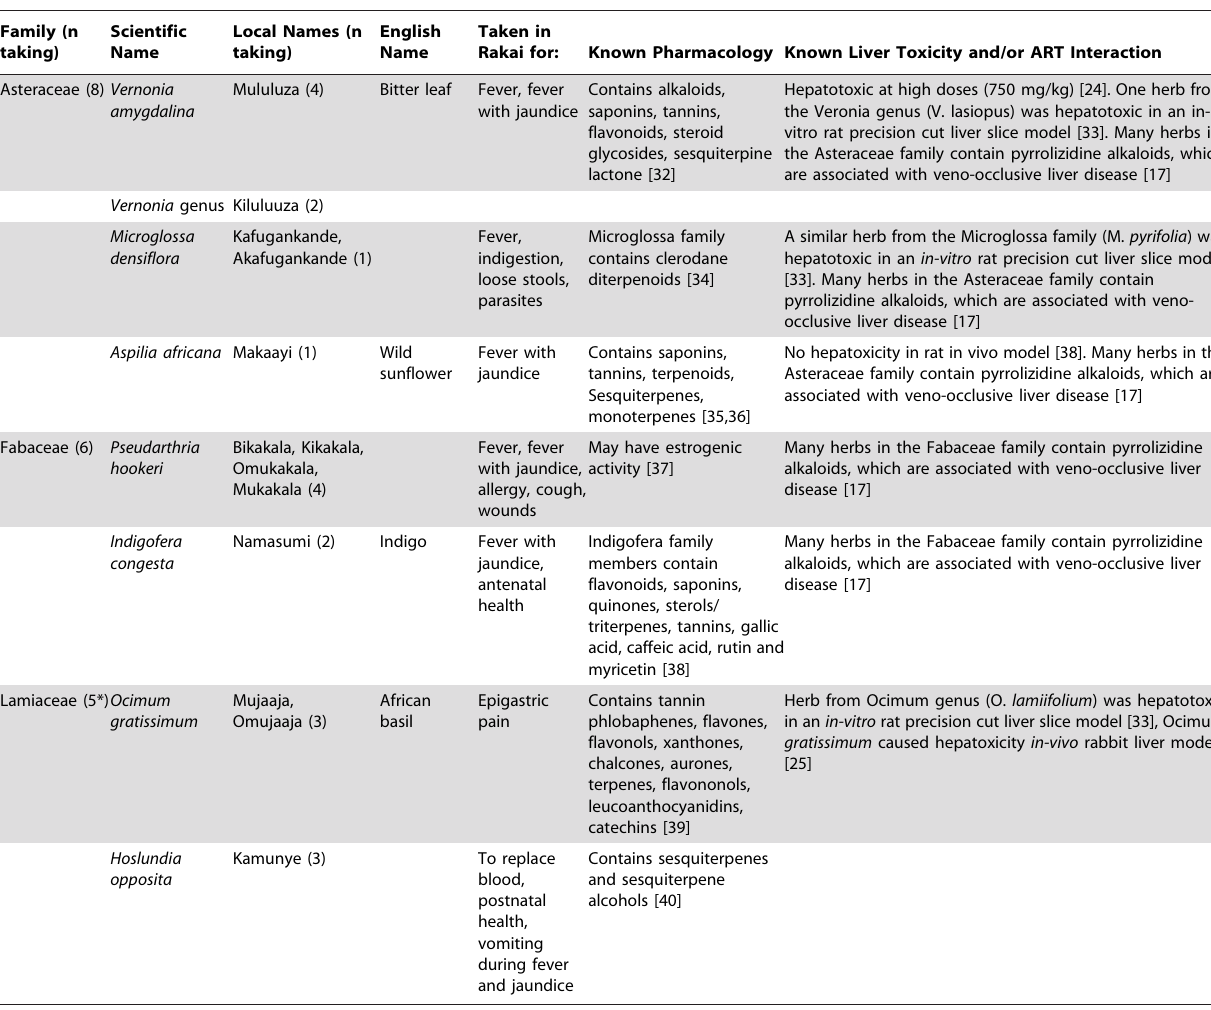
Table 3. Characteristics of known herbs in the Asteraceae, Fabaceae, and Lamiaceae families.